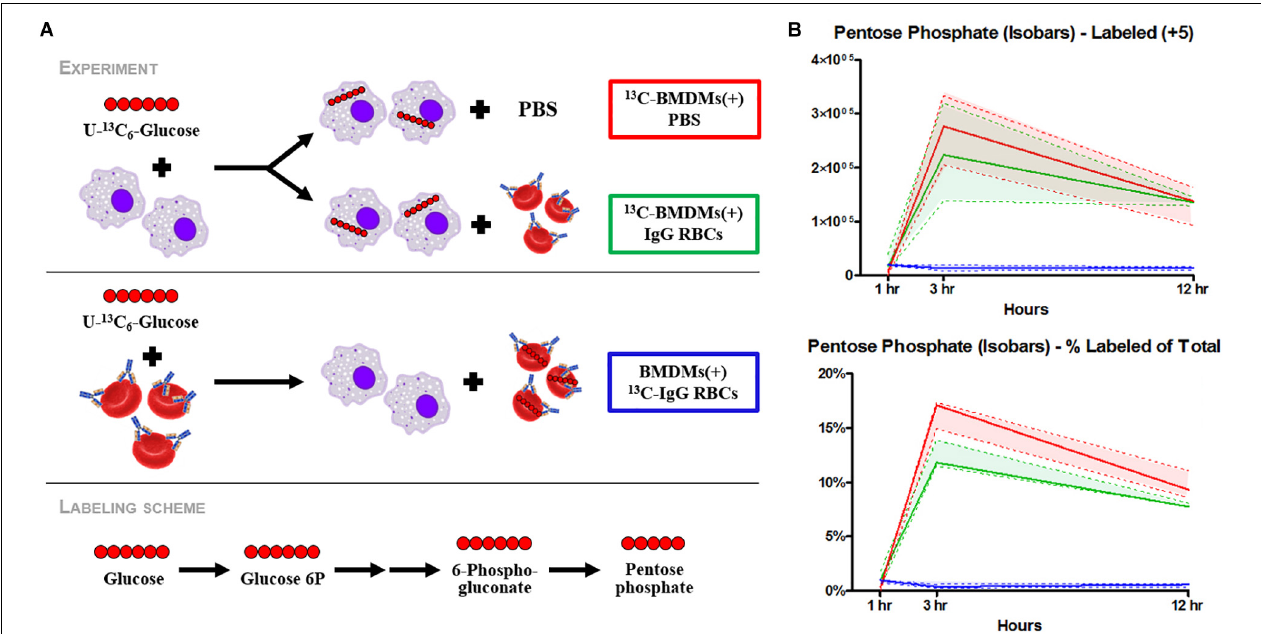
FIGURE 3 | Flux analysis of BMDMs incubated with heavy labeled substrates. BMDMs in PBS ( red ) or with IgG-opsonized RBCs ( green ) were uniformly labeled with 13 C 6 -glucose (A) . Experimental results of 13 C 6 -glucose detection in BMDMs (B) . Enrichment of the + 5 isotopologues of PPP metabolites, such as pentose phosphate isobaric isomers, were observed ( top ). Total percent labeled amounts of these isomers are shown in the bottom panel. These carbons are derived from glucose flux from the Embden-Meyerhof glycolytic pathway through the PPP. Continuous lines reflect the median of the three groups; whereas, the dashed lines represent interquartile